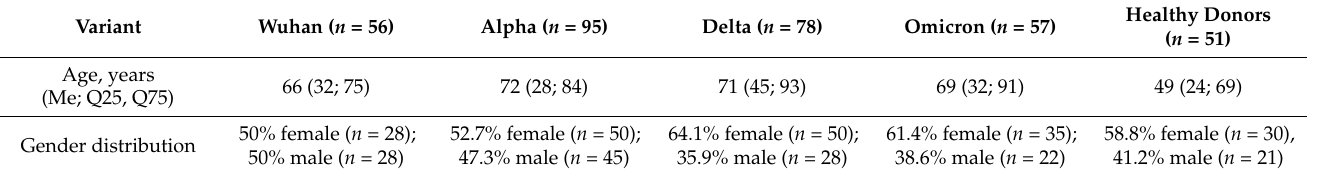
Table 1. Characterization of patients and healthy donors’